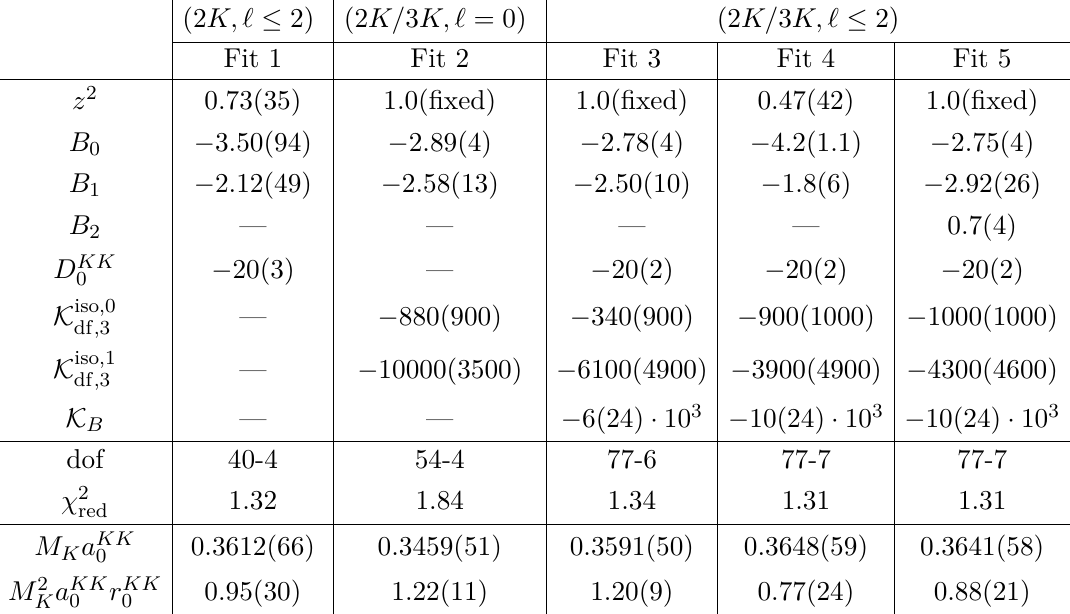
Table 11. Fit results for kaons on the D200 ensemble using M K L = 9 . 994083 , with notation as in table 9. Each fit contains all 2 K + and 3 K + energy levels (in the appropriate irreps) below E ∗ = 2 . 53 M K and E ∗ = 3 . 53 M K , max 2 , max